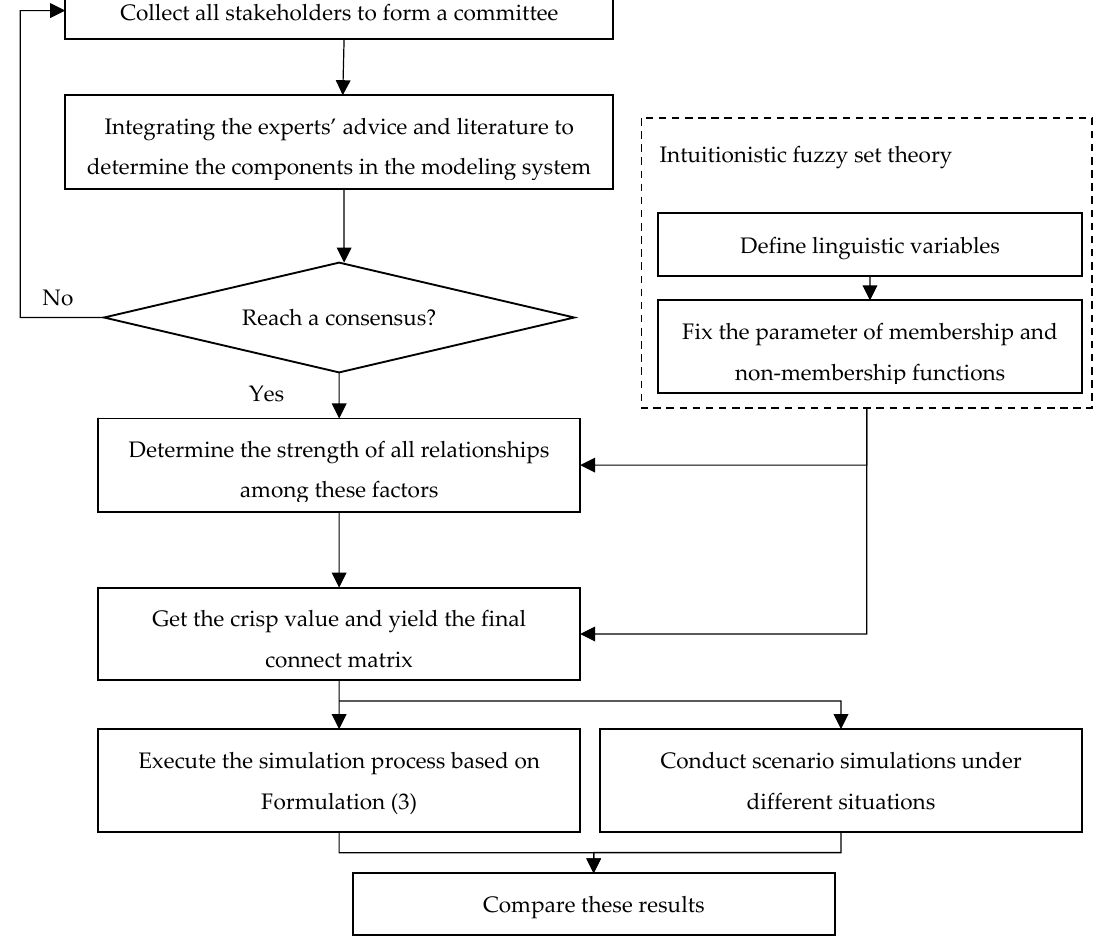
Figure 3. The process of intuitionistic fuzzy cognitive map (IFCM).